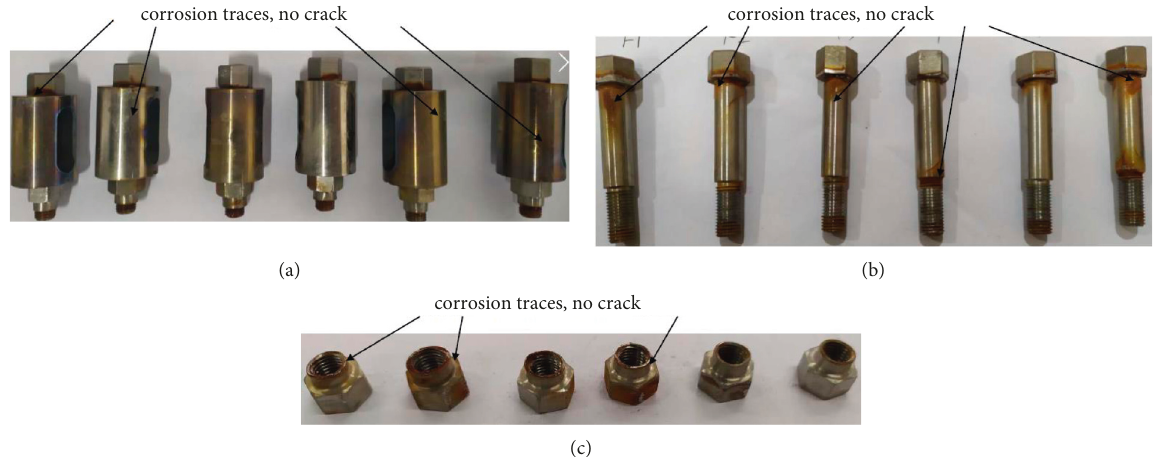
Figure 5: The status of test piece after test. (a) The state of the test piece in the combined state after the test. (b) The state of the bolt after the test. (c) The state of the nut after the test.